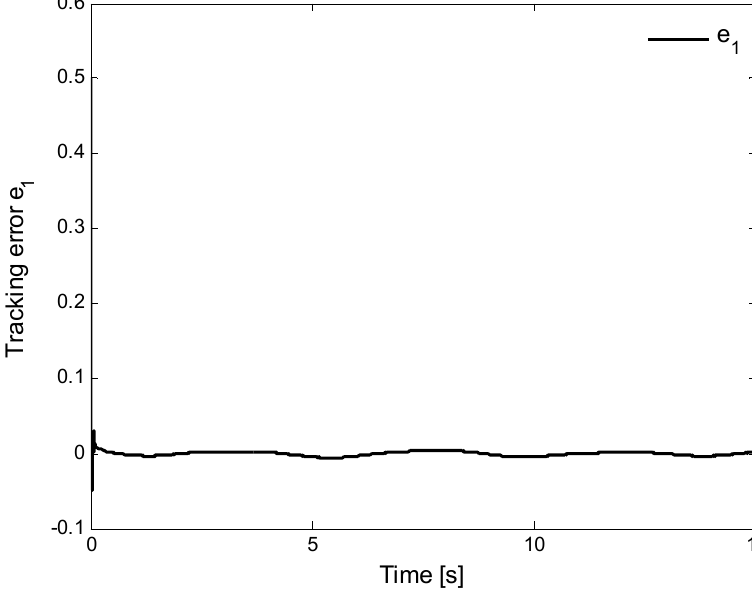
Figure 3. Trajectory of tracking error e 1 ( t )